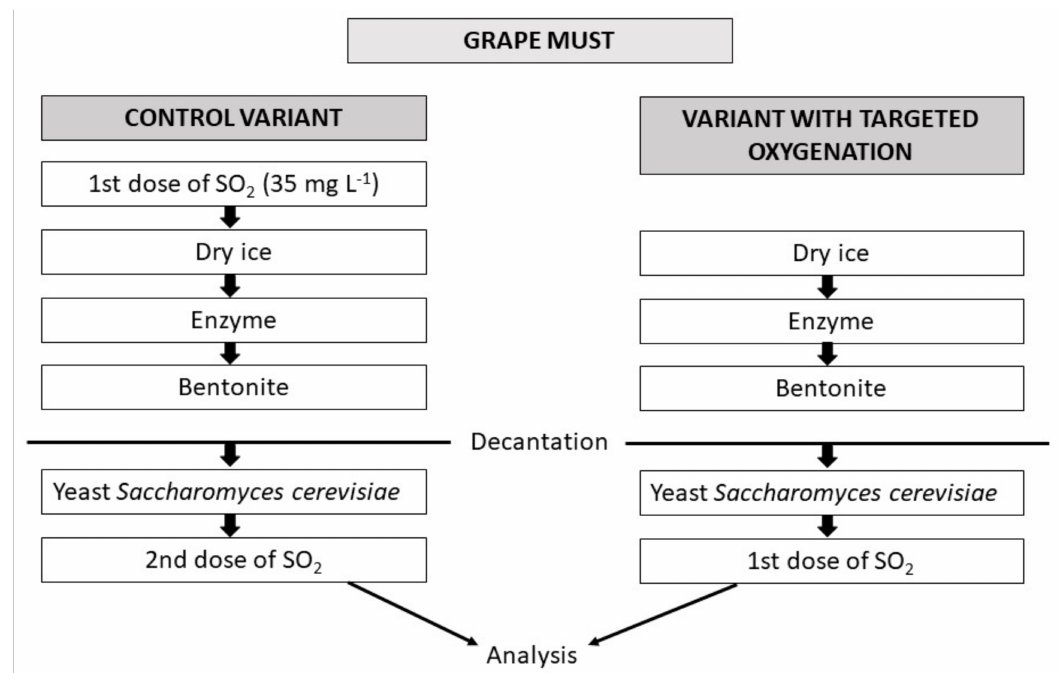
Figure 1. Experimental design of the control variant and variant with targeted